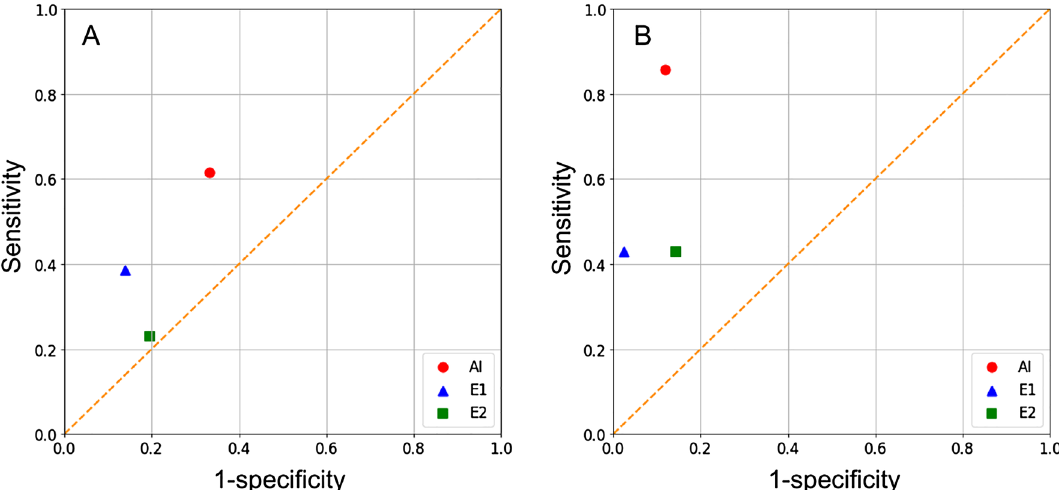
Figure 3. Comparison of the performance between the artificial intelligence model (AI), experienced human examiner (E1), and less experienced human examiner (E2) in predicting residual retinal fluid after initial treatment. In the ranibizumab group ( A , n = 49), the sensitivity and specificity of the AI model are noted to be 0.615 and 0.667, respectively. In the aflibercept group ( B , n = 49), the values are 0.857 and 0.881, respectively. Overall, the AI model shows comparable or relatively superior sensitivity and specificity than the human